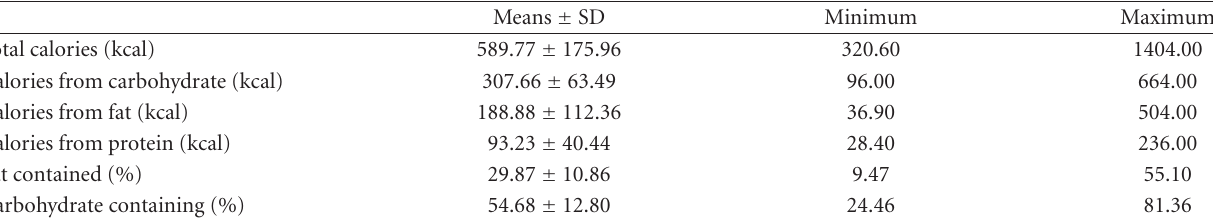
Table 4: Lunch menu selected by participants from school cafeteria (total = 108